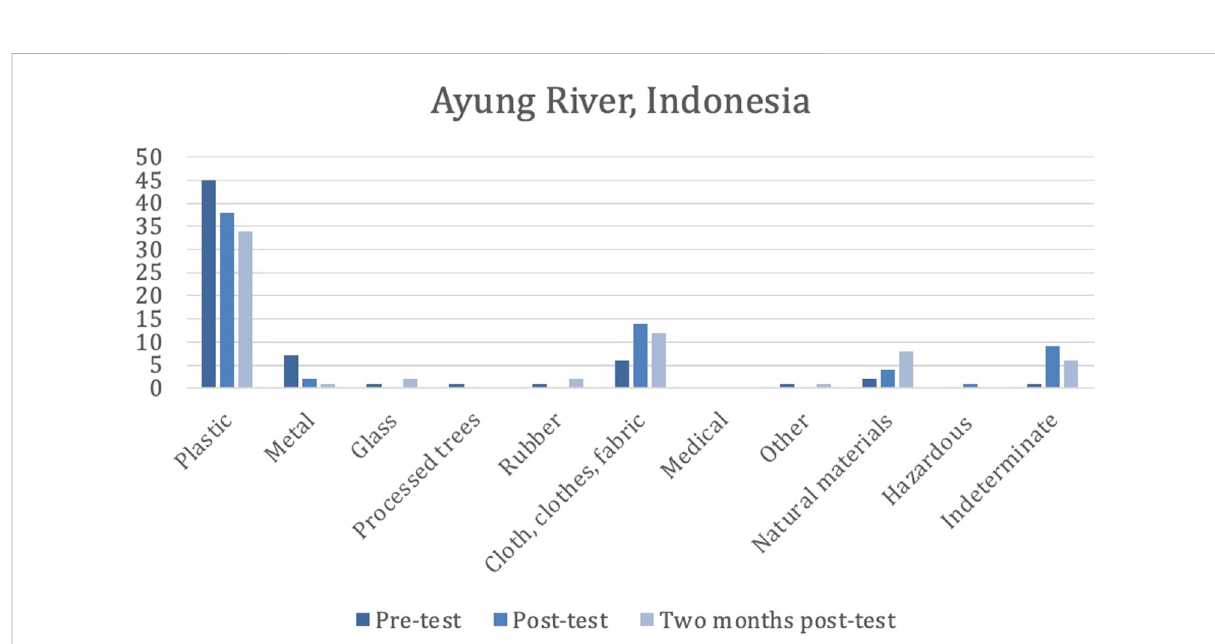
FIGURE 4 Participant perceptions of the most frequently found items in the Ayung River by